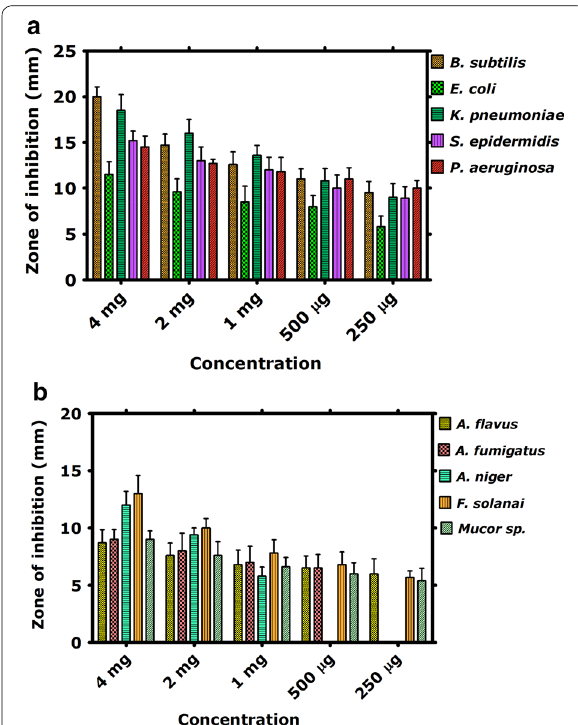
Fig. 5 Antibacterial and antifungal potential of BiVO 4 nanorods across different concentrations. a Antibacterial activities; b antifungal